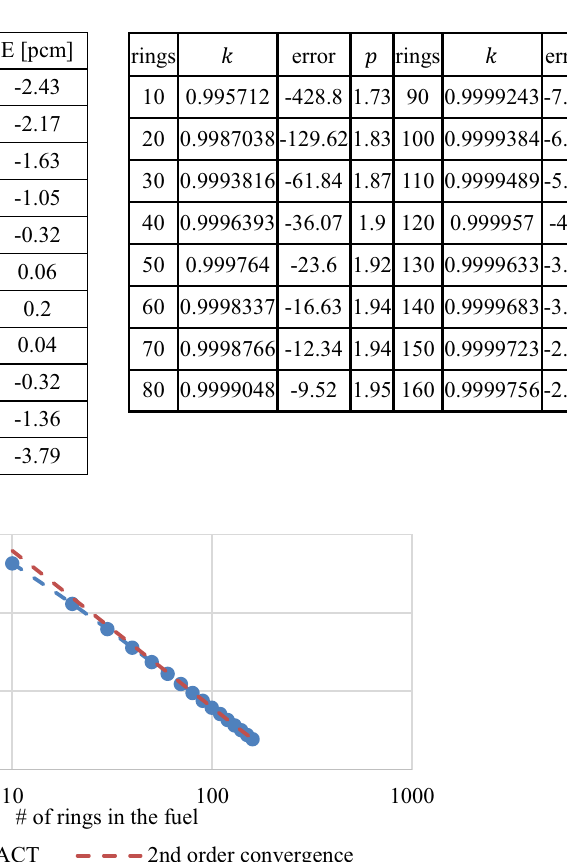
Table 3.1. MPACT k versus Critical Rod Radius Table 3.2. Error in (cid:10) [pcm] vs. # of rings in fuel